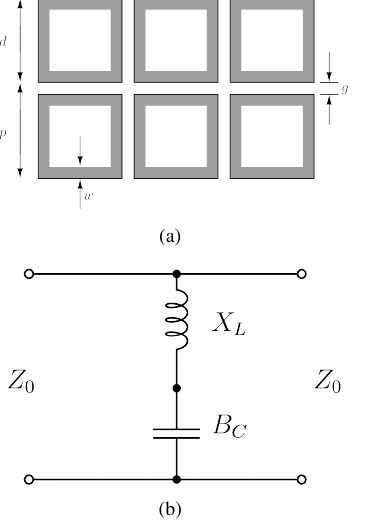
Figure 2: Square loop strucure (a); equivalent circuit (b)